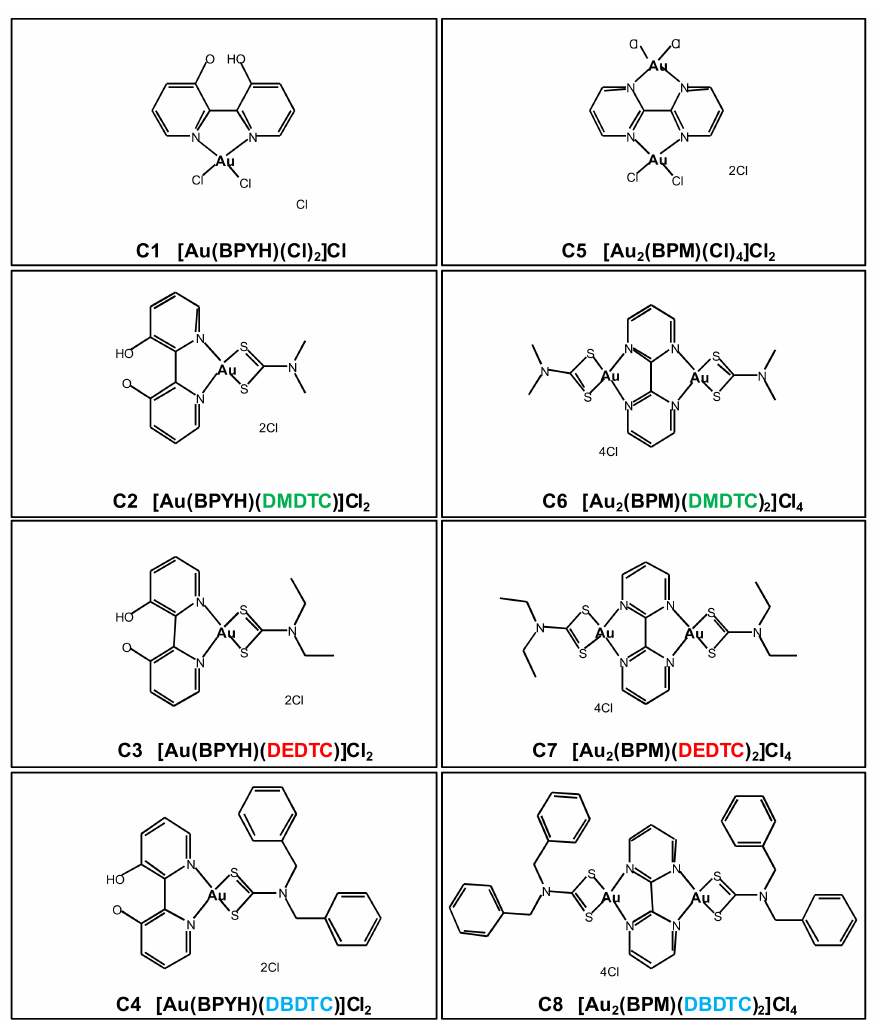
Figure 1. Chemical structures of the eight new gold (III) complexes (compounds C1 – C8 ). BPYH, 2,2 (cid:48) -bipyridine-3,3 (cid:48) -diol; BPM, 2,2 (cid:48) -bipyrimidine; DMDTC, dimethyldithiocarbamate; DEDTC, diethyldithiocarbamate; DBDTC,